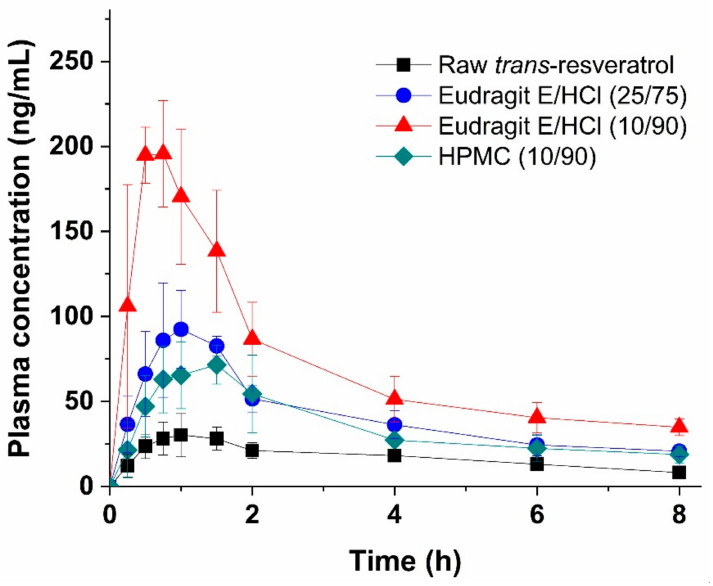
Figure 5. Plasma concentration-time profiles of raw trans -resveratrol and solid dispersion powders produced using the spray drying process after oral administration in Sprague-Dawley